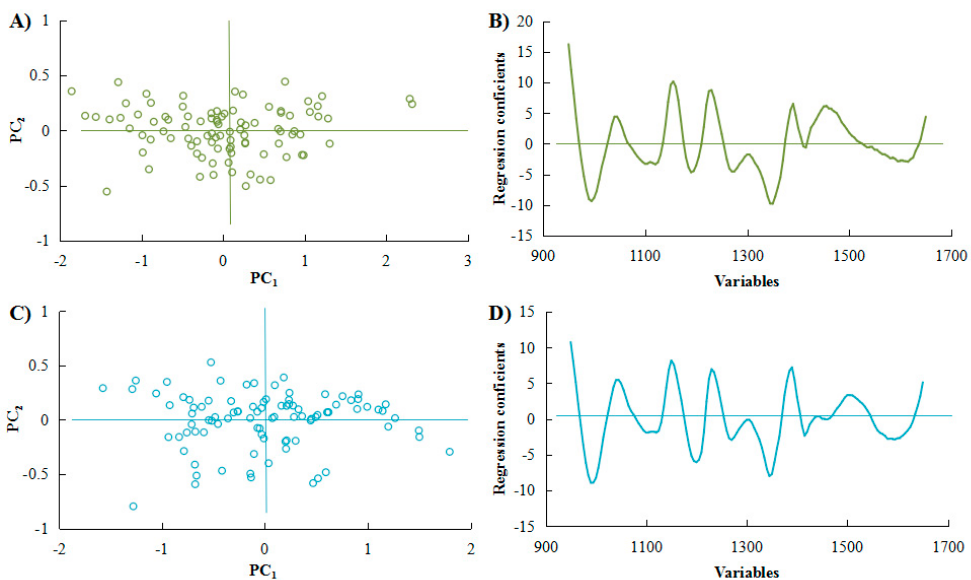
Figure 2. NIRS kernels oil content analysis of: Camellia gauchowensis Chang ( A , B ); and C. semiserrata Chi ( C , D ).